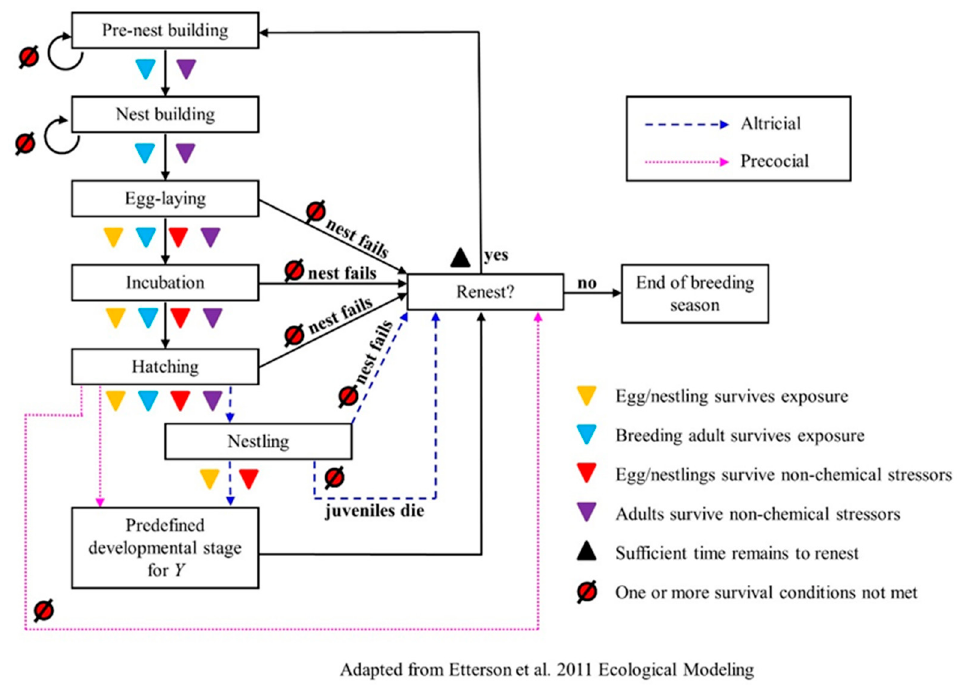
Figure 3. Conceptual model showing how chemical and other stressors are mapped onto an iterative model of avian seasonal reproduction. Y refers to the desired output from the breeding model, which is user-defined and could be number of successful broods, number of offspring produced, the probability of at least one successful brood, etc. Adapted from [29].